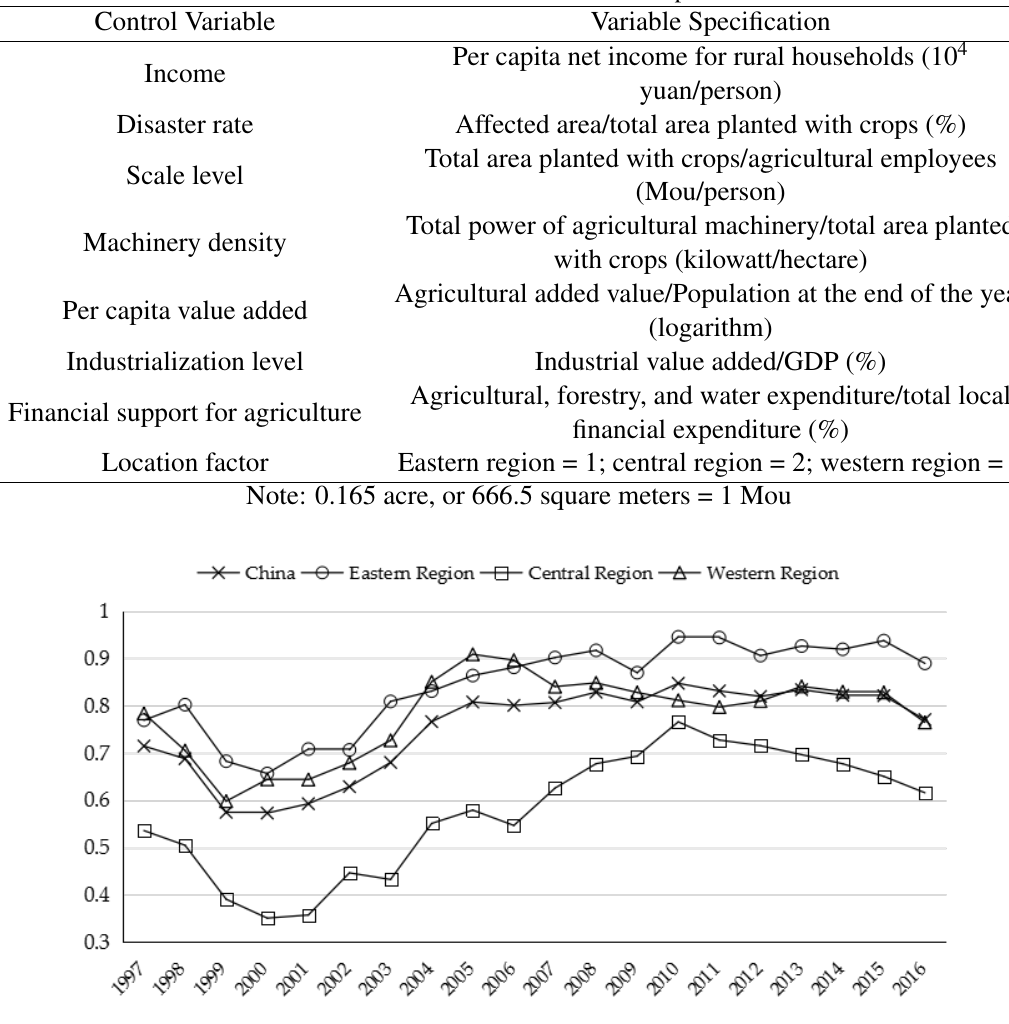
Fig. 1 Trends in agricultural GTFP in China and three separate regions from 1997 to 2016.